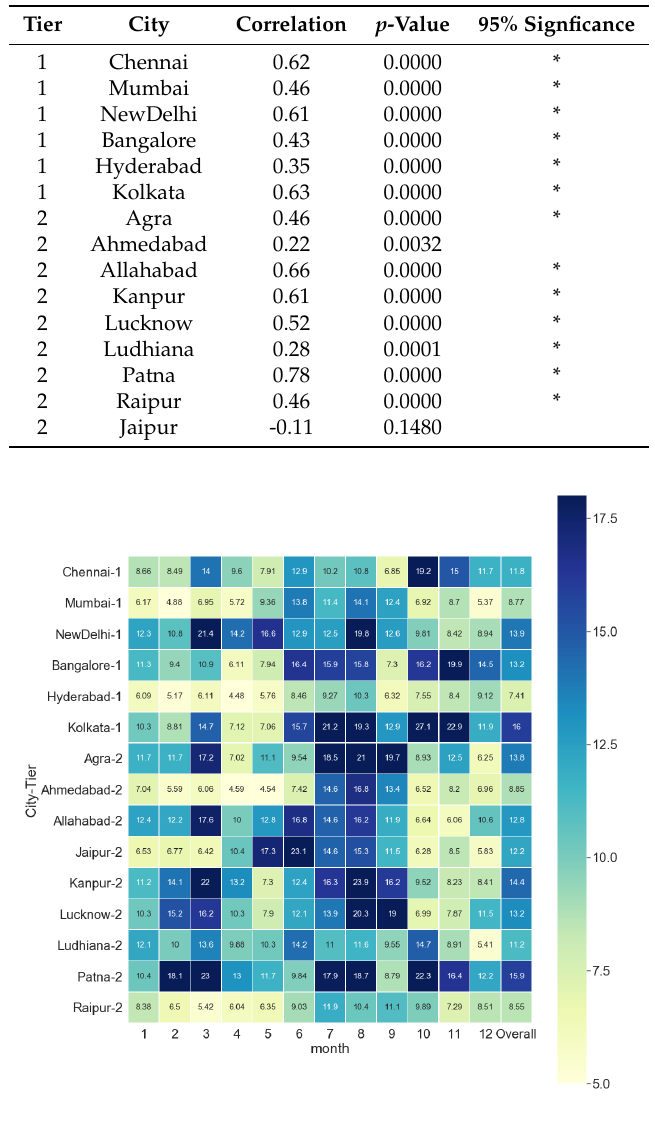
Figure 7. Increase in R est due to urban growth is compared with R obs over the selected cities in ( a – n ). m , s Months of July, August and September usually have missing observations due to cloud-cover. Table 4. Pearson’s correlation between R obs and R est for all years of the dataset 2001 to 2015. The significance was Bonferroni corrected to overcome multiple comparison problem. Significant correlations are den0ted by *.